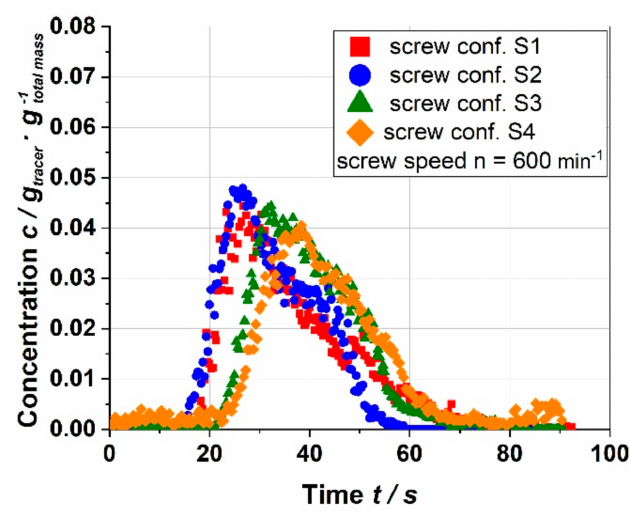
Figure 3. Residence time distribution for various screw configurations (screw speed: 600 min − 1 and water content: 22%, barrel temperature: 120 ◦ C; S1: only transport elements, S2: two reverse elements, S3: four reverse elements, S4: two reverse elements and a kneading block).